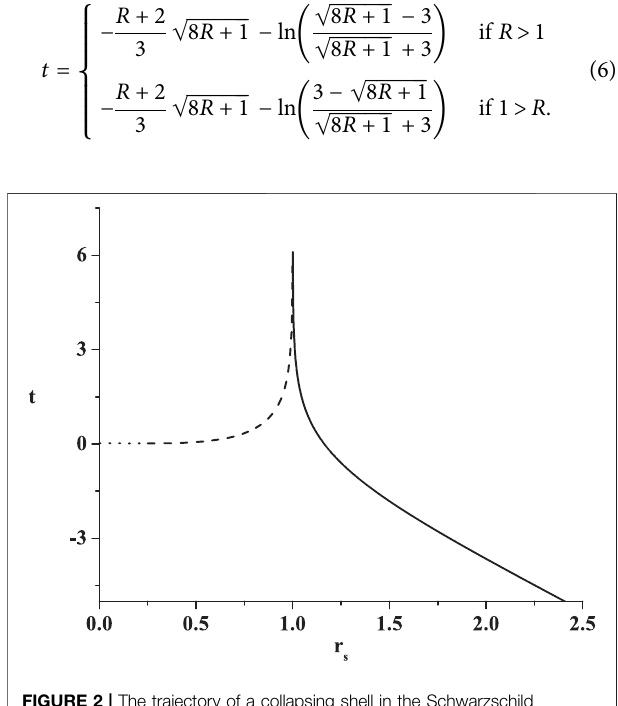
FIGURE 2 | The trajectory of a collapsing shell in the Schwarzschild coordinates( t , r ).Wesettherestmassoftheshell, μ ,anditstotalenergy, M ,to beequalto1/2.Theincipientblackholehorizonisat r =1.Thecollapsingshell takes in fi nite time to arrive to the horizon (solid line). However, a shell/ anti-shell pair is created with the radius R = 0.25. The positive energy shell shrinks to R = 0 (dotted line), while the negative energy one propagates outward(thedashedline),where fi nallyitcancelstheoriginalcollapsingshellat the horizon at t → ∞ .